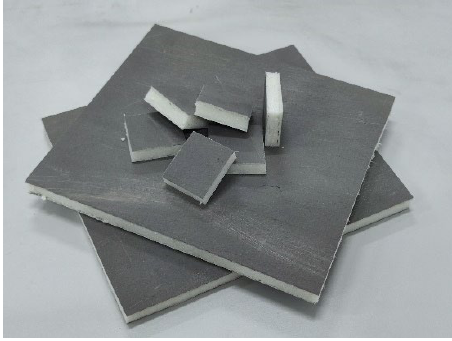
Figure 1. Waste rigid polyurethane insulation board.